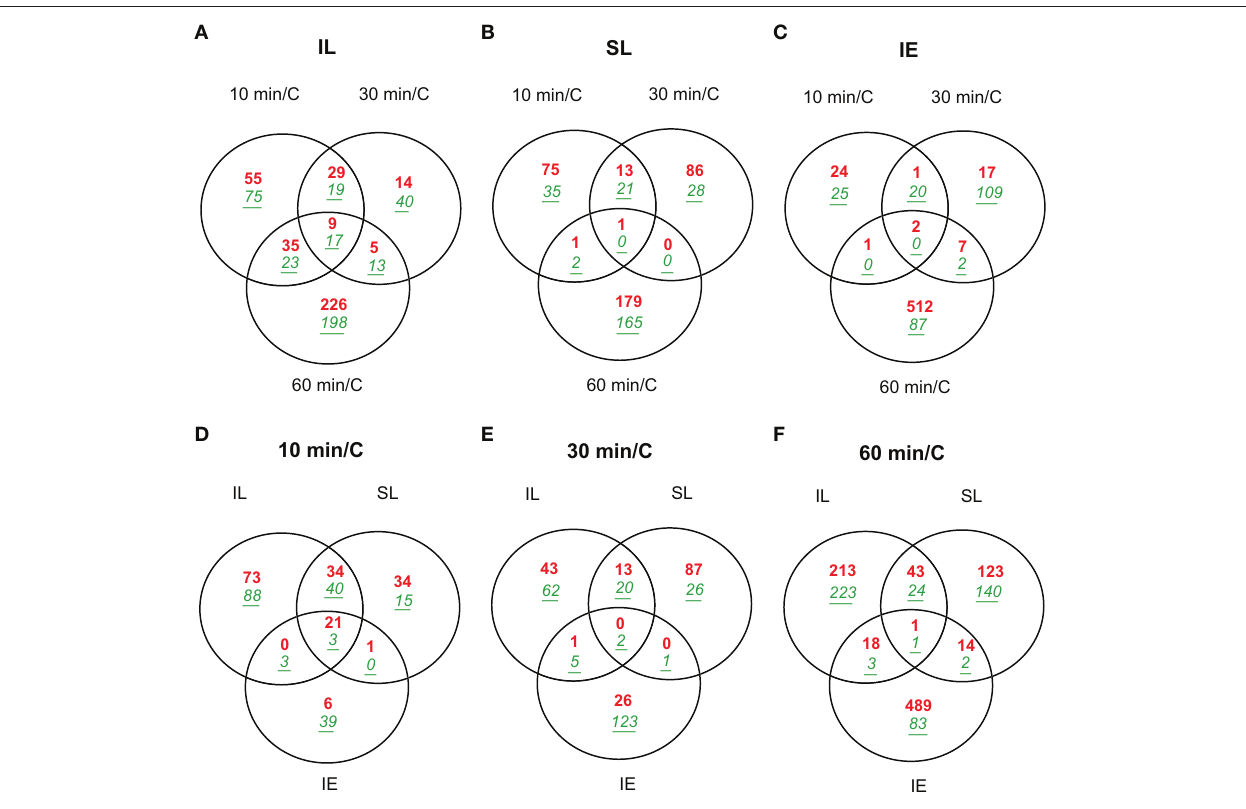
FigURe 2 | Venn diagrams comparing transcriptome changes in leaves and immature ears from UV-B-irradiated plants in only two adult leaves compared to non-irradiated control plants (C). Plants were irradiated over a time course of 10, 30, and 60 min. Intersection of genes differentially expressed in irradiated leaves (A) ; shielded leaves (B) ; and immature ears (C) during 10, 30,